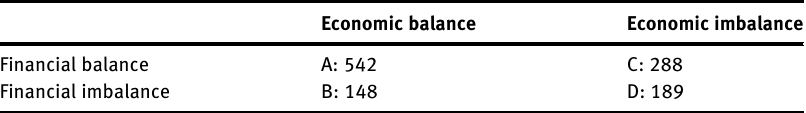
Table  : Matrix of fi nancial and economic health, year  .